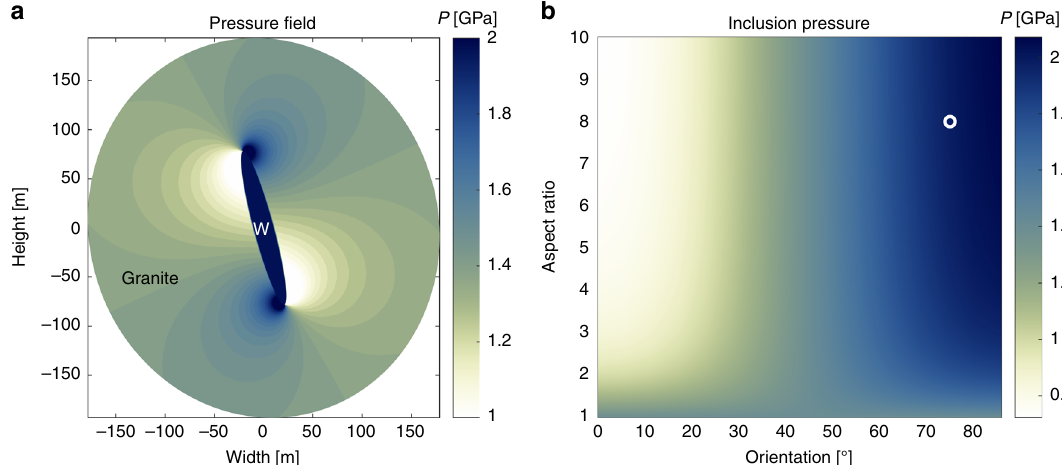
Fig. 6 Analytical solution of pressure distribution between a weak inclusion and a strong host. Calculated pressure ( P ; using solution of ref. 45 ) for a mechanically weak elliptical inclusion within a medium that is 100 times mechanically more competent. The model con fi guration represents a NW-vertical section of Fig. 1b, with width referring to NW and height to the vertical direction. a Colourplot of pressure fi eld for a representative con fi guration. The pressure in the elliptical inclusion is homogeneous. The aspect ratio of the ellipse is 8. Compression direction is horizontal (parallel to width direction) and at an angle of 75° with respect to the ellipse long axis. Far- fi eld compressive stress has both a mean and differential stress of 1.4 GPa. The elliptical inclusion (labelled W) mimics the whiteschist and the surrounding medium (labelled Granite) the stronger metagranite. b Colourplot of pressure, P , in the inclusion as a function of inclusion aspect ratio and orientation of inclusion long axis with respect to compression direction. The white circle indicates the con fi guration displayed in a . Orientations between ca. 70 and 90°, and aspect ratios >ca. 4 generate inclusion pressures of >ca. 2